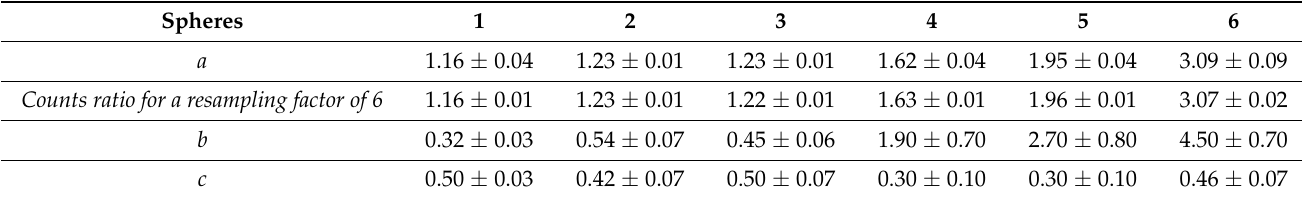
Table 4. Parameters obtained by the fit with the function f(x) = a − b × c x . The a parameter represents the asymptote. Spheres